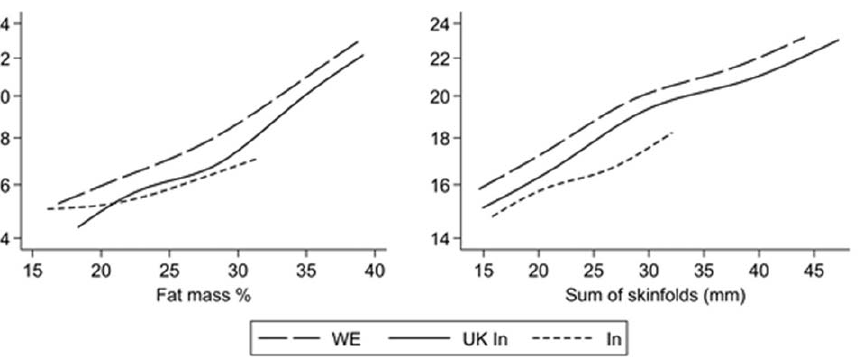
Figure 1. Interrelationships between measures of adiposity adjusted for age in white Europeans (long dashes), UK Indians (solid line) and Indians (short dashes) using median splines. Data are adjusted for age and presented between the 5 th and 95 th percentiles for the variable on the horizontal axis by removing the bottom 5 th and top 5 th centiles from each population group separately. The y-axis is on the log scale.